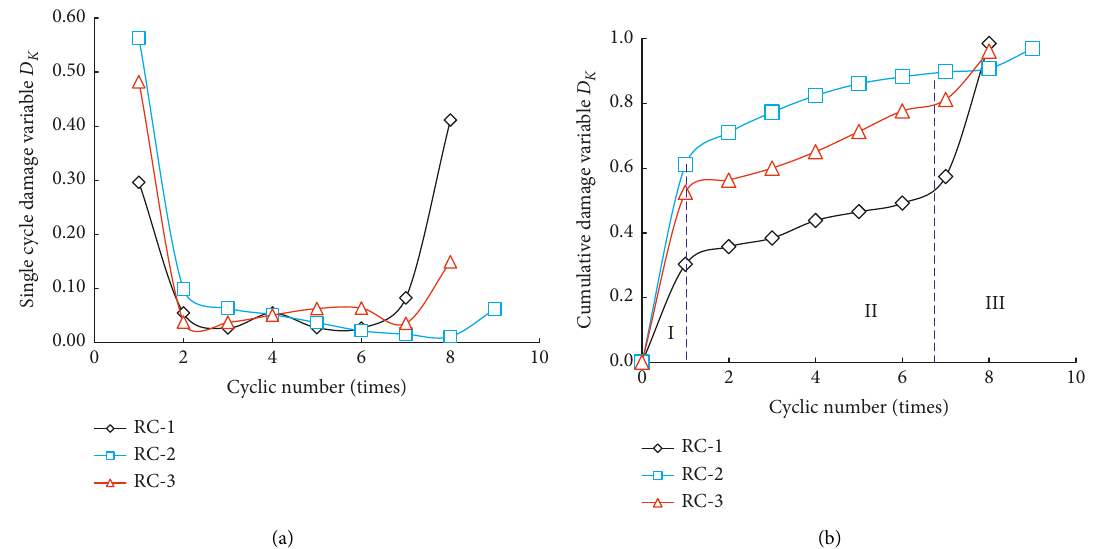
Figure 9: Damage variable curve based on seepage characteristics: (a) D